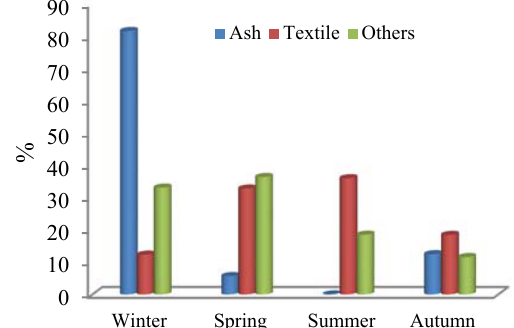
Fig. 5: According to season percentage of ash, textile and other wastes